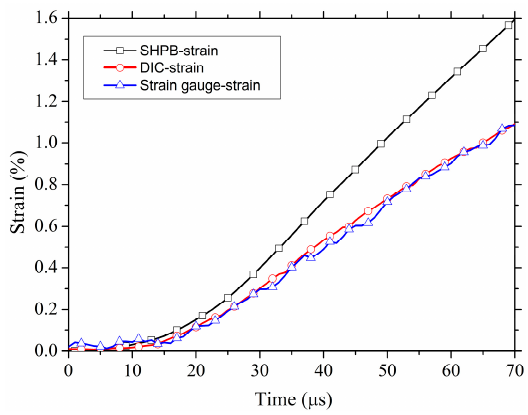
Figure 6. Comparison of time-dependent curves of different strain-measuring methods.